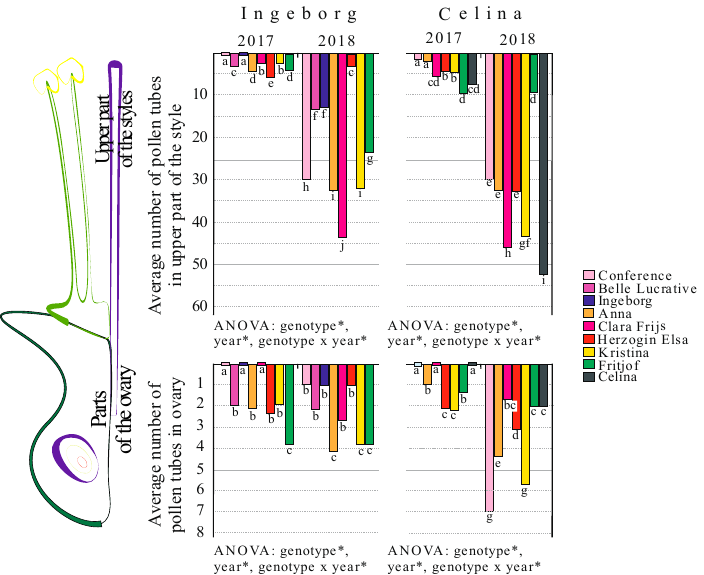
Figure 5. Average number of pollen tubes in the upper part of the style and ovary in the pear cultivars “Ingeborg” and “Celina” in different combinations of pollination in 2017 and 2018. (Different letters below the bars denote a significant difference between clones according to the LSD test, p < 0.05).